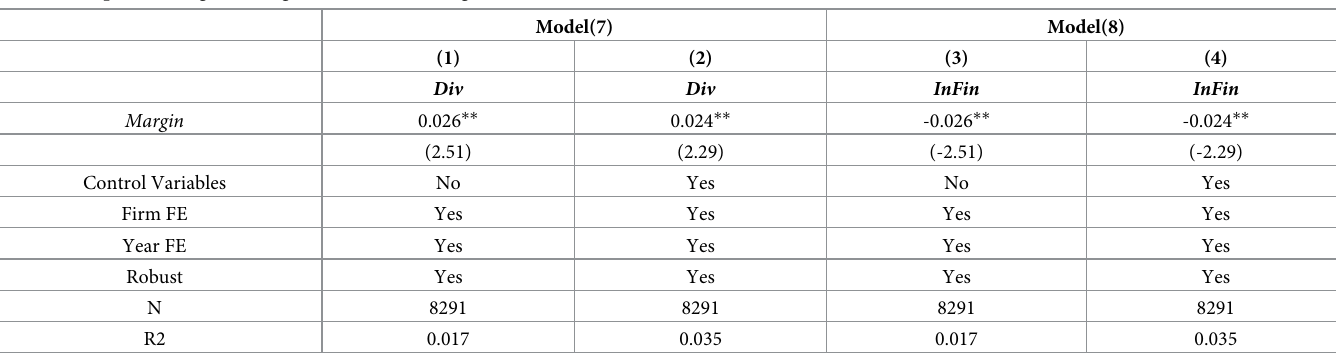
Table 15. Impact of margin trading on internal